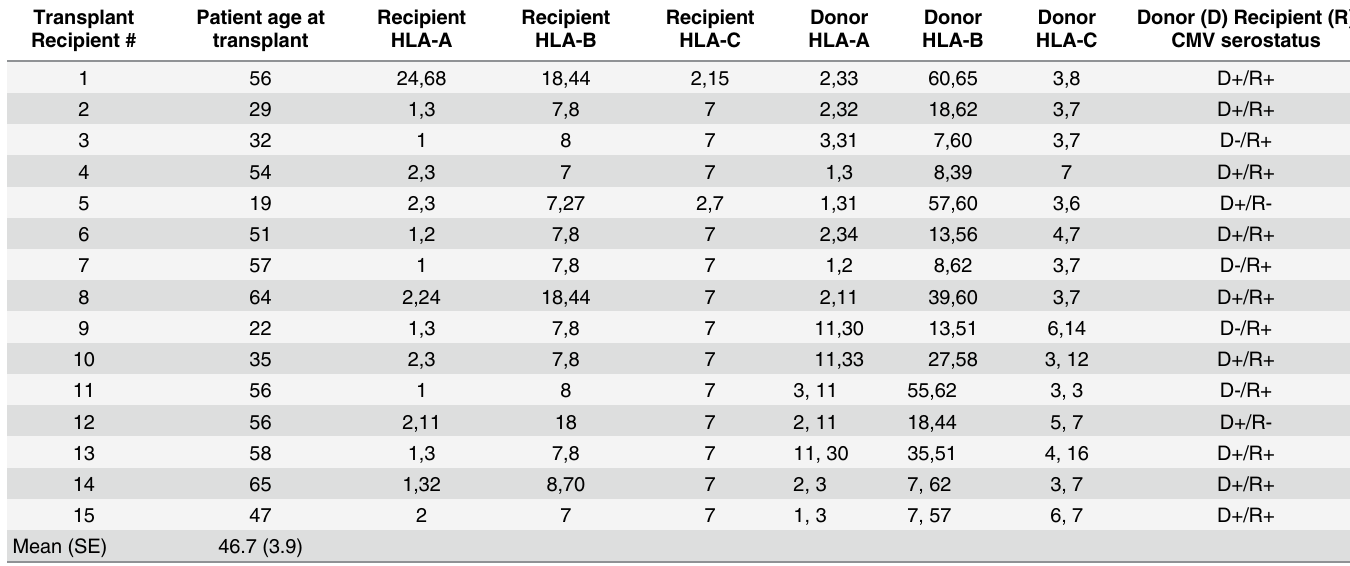
Table 1. Lung transplant recipient